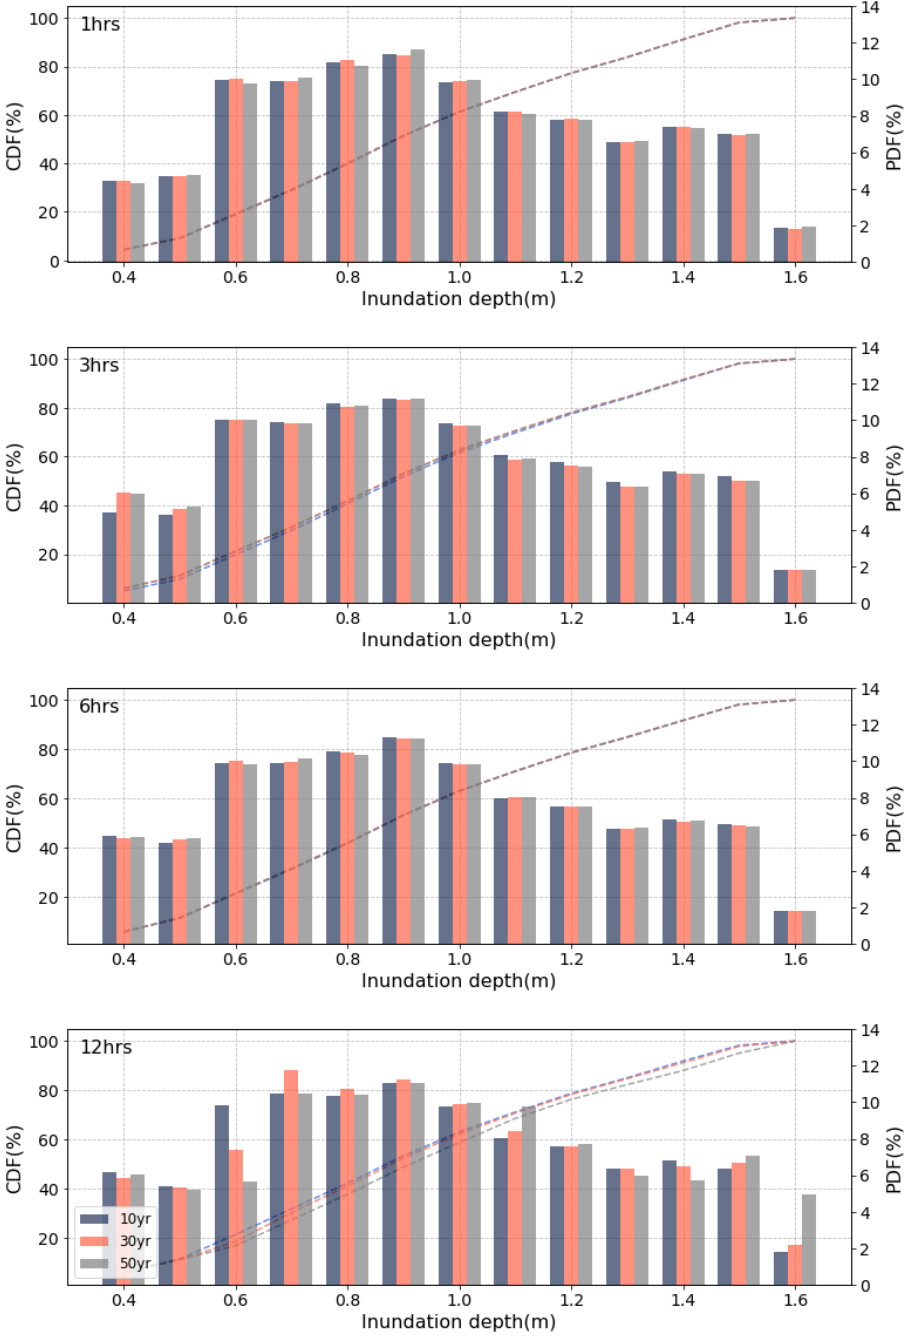
Figure 6. PDF and CDF of simulated inundation depth for target period I (2010 – 2040). A typical result of future inundation analysis is that the proportion of cells with a higher inundation depth increases as the target period increases. For example, the propor- tion of cells in which the inundation depth is 1.4 m or more ranges from 1 to 5% in the current or target period I scenario (i.e., 2010 – 2040), but in target periods II and III (i.e., 2040 – 2100), it ranges from 6 to 14% of the total flooded area in the city. Moreover, in target